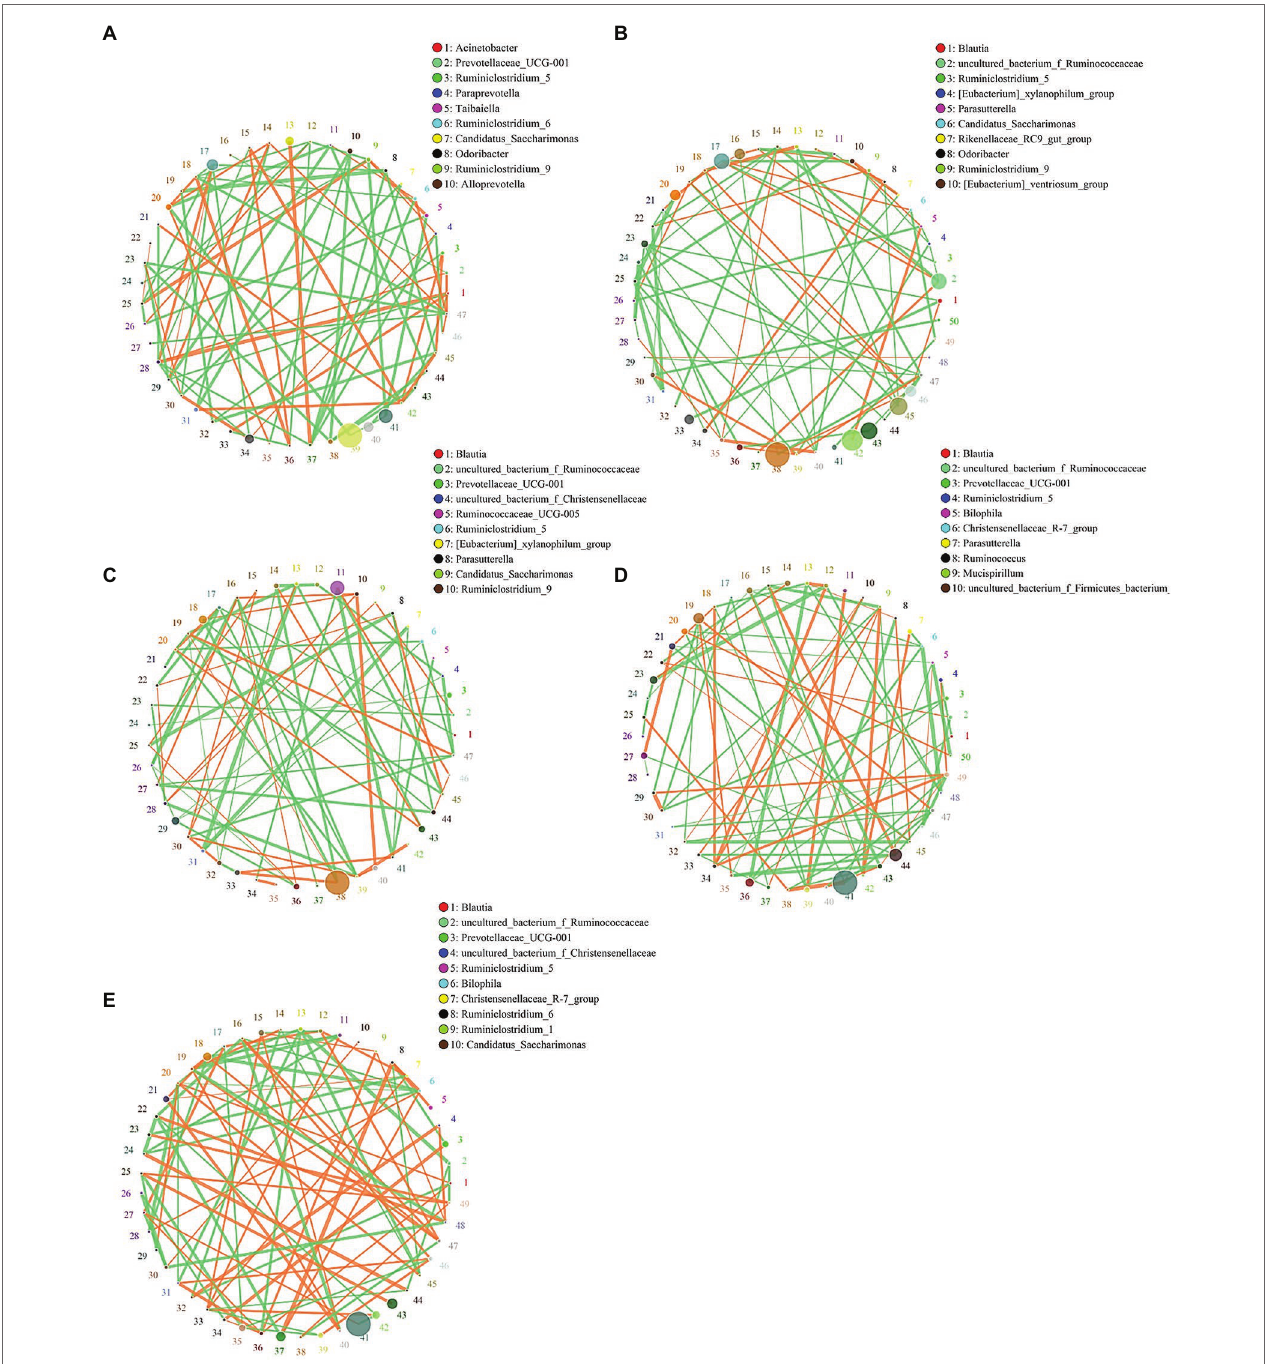
FIGURE 6 | Correlation of microbiota at genus level in the intestines of five groups of mice, including the CTL group (A) , the Model group (B) , the Model + β -carotin group (C) , the Model + GTP group (D) , and the Model + Double group (E) . The size of the circle represents the relative abundance, the line represents the correlation between the two taxa at both end of the line, the thickness of the line represents the strength of the correlation, the orange line represents positive correlation, and the green line represents negative